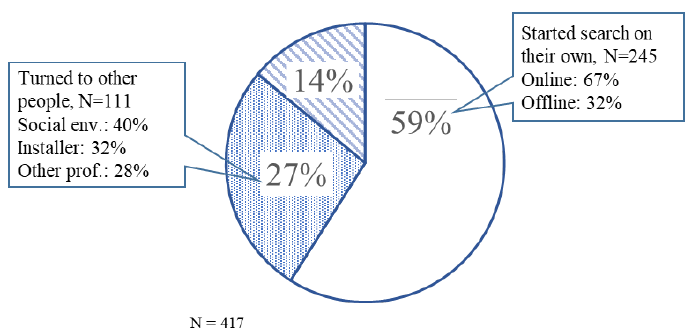
Figure 6. Information search behavior and sources of information.